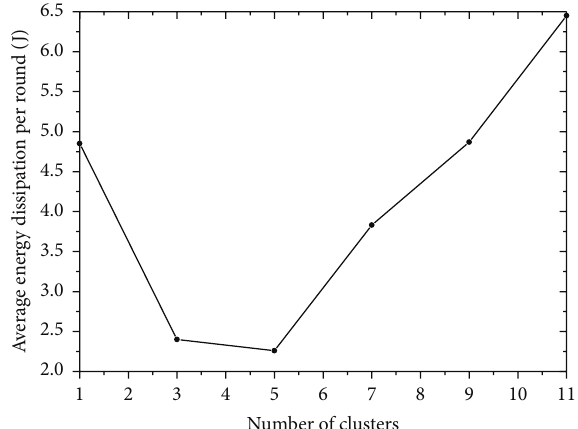
Figure 1: The relationship of cluster number and energy consump- tion in the scene of 100 nodes in